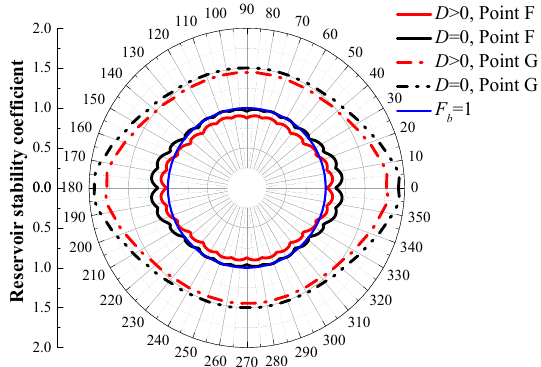
Figure 17. The distributions of polar coordinates of the reservoir stability coefficient with and without considering damage of hydrate-bearing sediments at different positions.